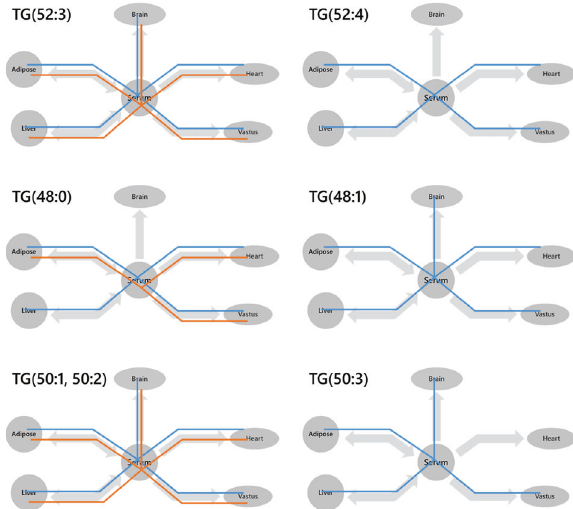
Fig. 6 Wiring (London Underground) diagrams of triglyceride (TG) variables found in which tissues. Blue lines represent the lean group whereas orange lines represent the obese-GDM group. A variable was considered present if B = >